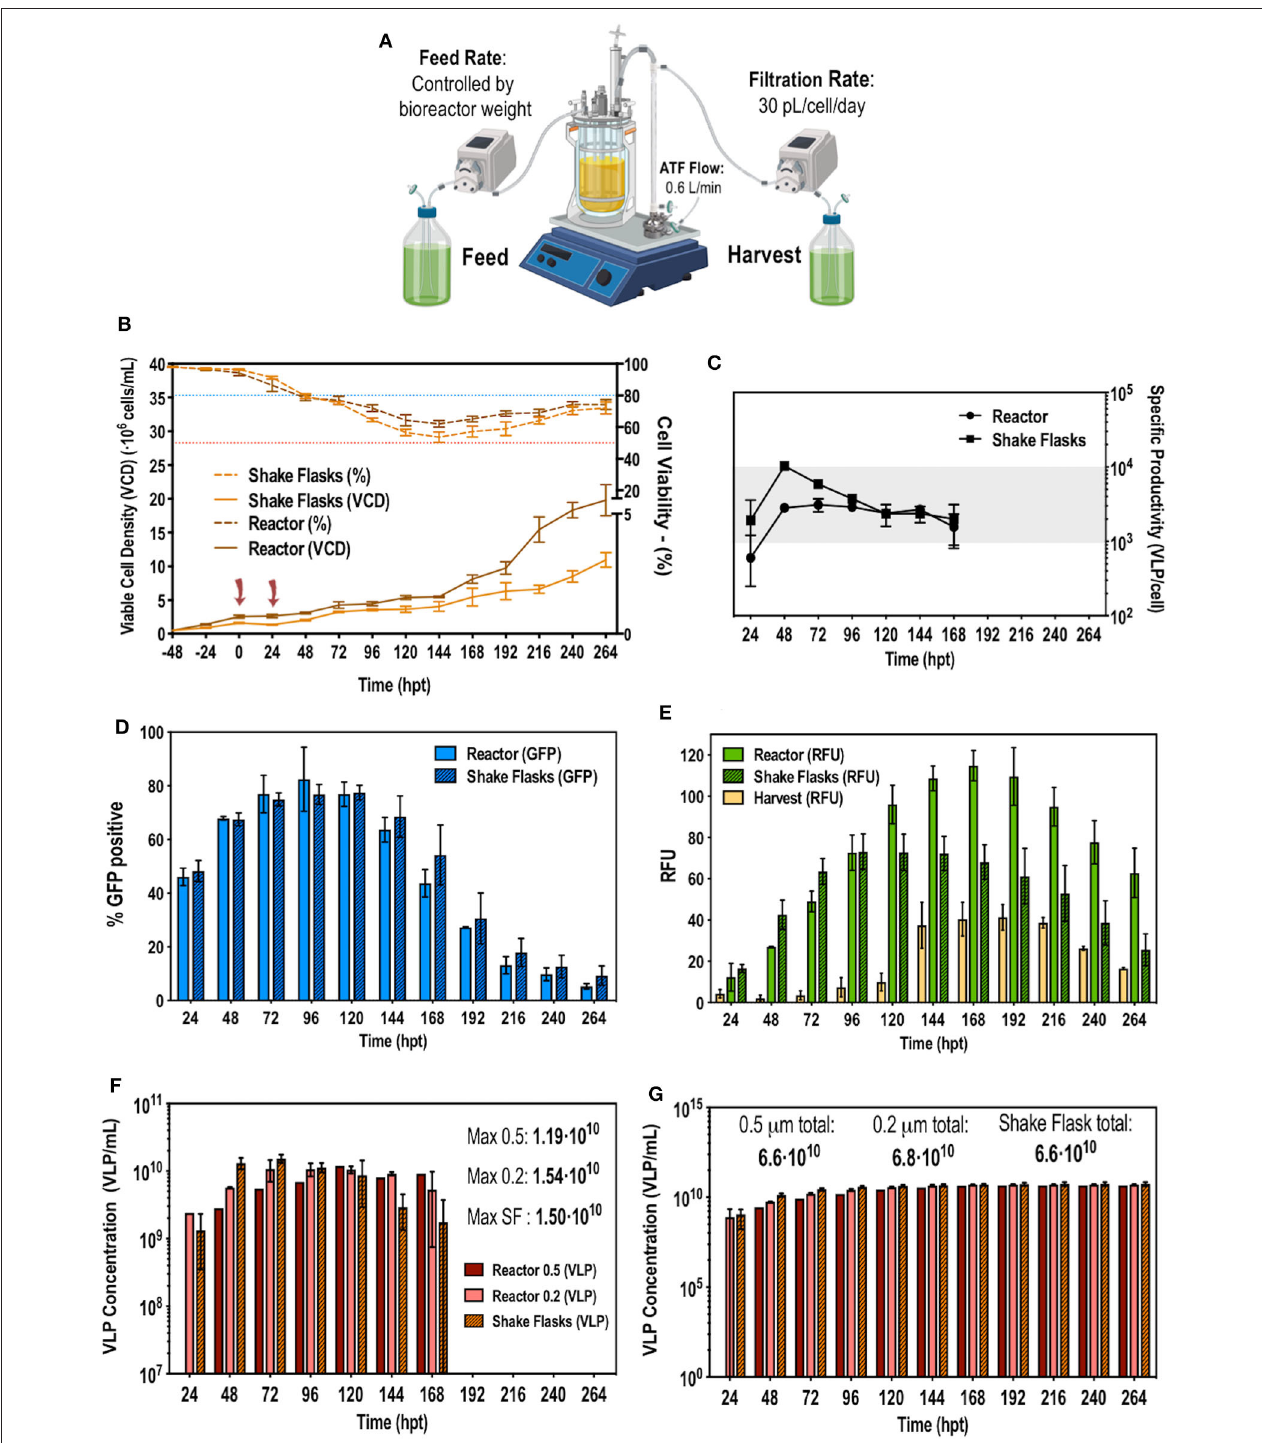
FIGURE 3 | (A) Schematic representation of the implemented ATF perfusion system. (B) Viable cell density and cell viability graphs along the studied time course. The blue and red dotted line indicate 80 and 50% of cell viability, respectively. Cells were transfected at time point 0 and 24h post-transfection (hpt) noted by red arrows. (C) VLP specific productivity rate along the studied time course. (D) Flow cytometry analysis of the transfection percentage (showed in GFP positive percentage of cells) along the time course. (E) Measurements of f luorescence in relative fluorescent units (RFUs) from the reactor, the harvest and the shake flasks. (F) Total VLP concentration produced per day. Two different pore size for the hollow fiber module were used in the ATF system: 0.5 and 0.2 µ m denoted as 0.5 and 0.2, respectively. (G) Total cumulative VLP concentration. Experiments performed n = 3.